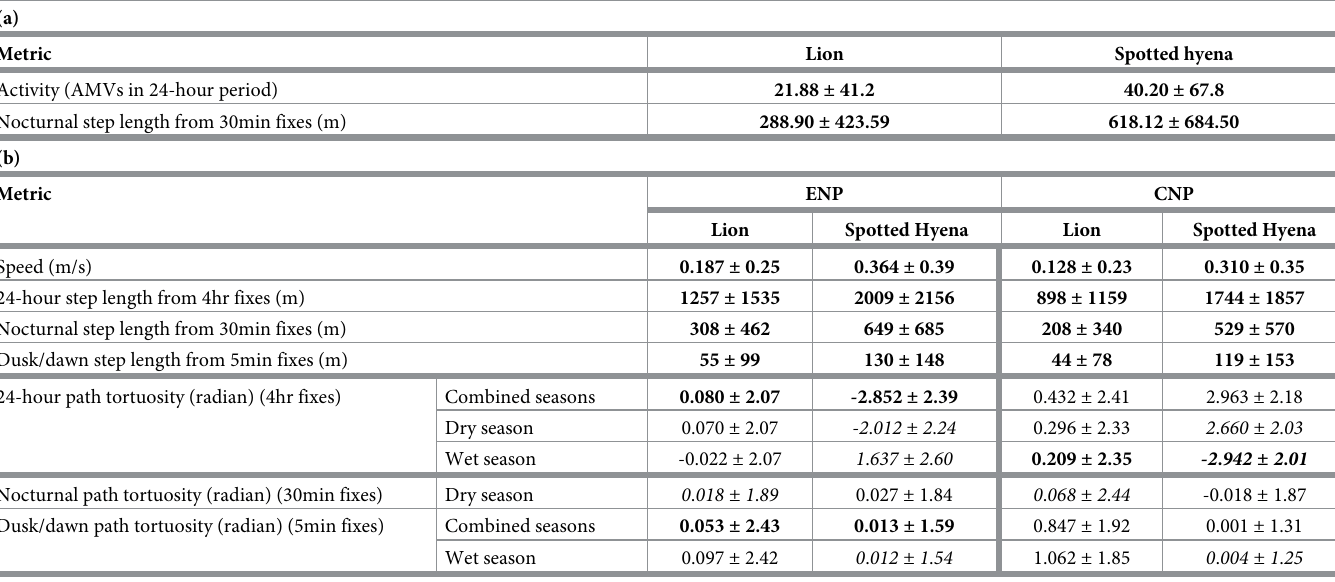
Table 5. Lion and spotted hyena movement metrics from protected